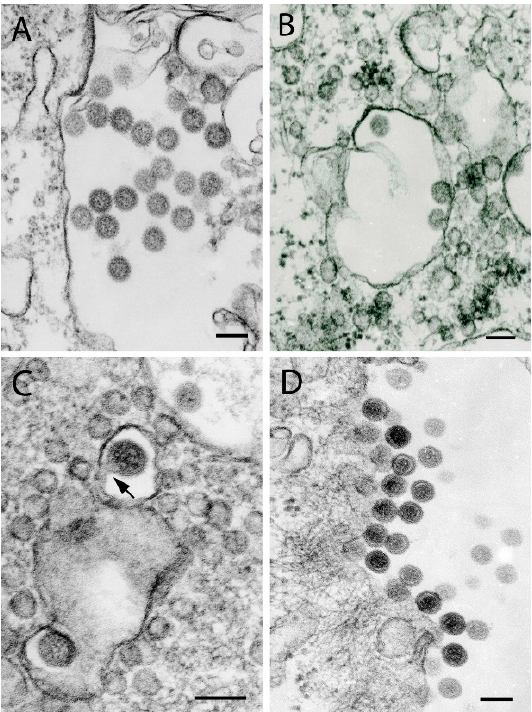
Figure 4. Ultrastructure of tick-borne viruses likely to be assigned to the genus Phlebovirus . ( A ) Sunday Canyon virus, Uukuniemi species group. Extracellular virions 75–85 nm in diameter at the cell surface. ( B ) Bhanja virus (strain IbAr 2709), Bhanja group. Three virions 75 nm in diameter in an intracytosolic vacuole. ( C ) Severe fever with thrombocytopenia syndrome (SFTS) virus, SFTSV-Heartland group. Virions 70–80 nm in diameter forming into intracellular vesicles (arrow) in a DH82 cell. ( D ) Heartland virus, SFTSV-Heartland group. Virions 85 nm in diameter at the cell surface of a Vero E6 cell. Bars = 100 nm.